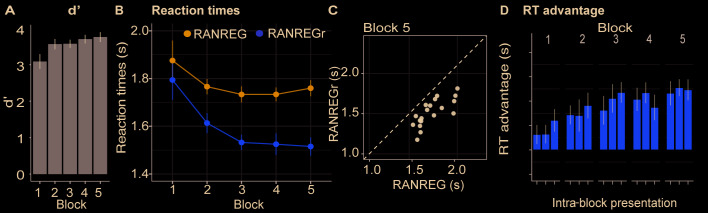
Experiment S1 (N = 19): implicit memory for six concurrent patterns.(A) Sensitivity to emergence of regularity (d') across blocks. (B) RT to the RAN to REG transition in RANREG and RANREGr conditions across blocks. ﻿(C) The relationship between RTs to the RANREG and RANREGr conditions in block 5. Each dot represents an individual participant. All participants exhibited implicit memory of reoccurring patterns by the end of the 5th block. (D) RT advantage for each intra-block presentation. A progressive RT advantage emergeed even when six different REGr were presented. Plotted values correspond to the RT advantage of REGr for each intra-block presentation. RTs of 1st, 2nd or 3rd intra-block presentations were averaged across the different REGr, and RTs to novel REG were averaged across trials which occurred at the beginning (first third), middle or end of each block. Note that this analysis is based on a small number of trials per ‘intra-block’ presentation condition, and effects are therefore somewhat noisy. Error bars indicate 1 s.e.m.